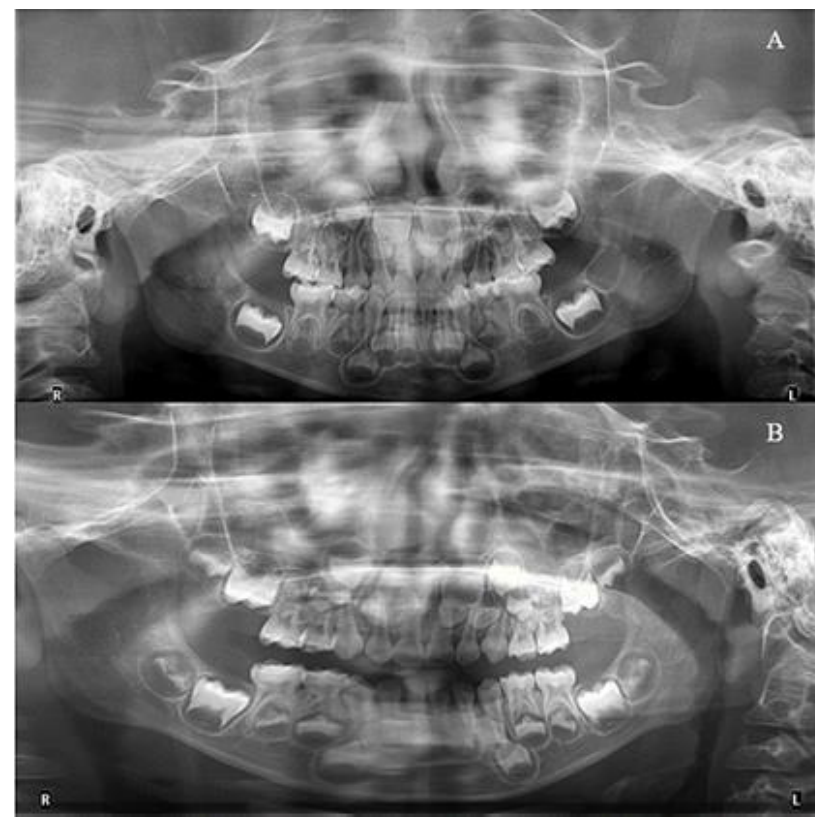
Figure 4. The initial and final radiographs. ( A ): Pre-treatment; ( B ): Post-treatment.